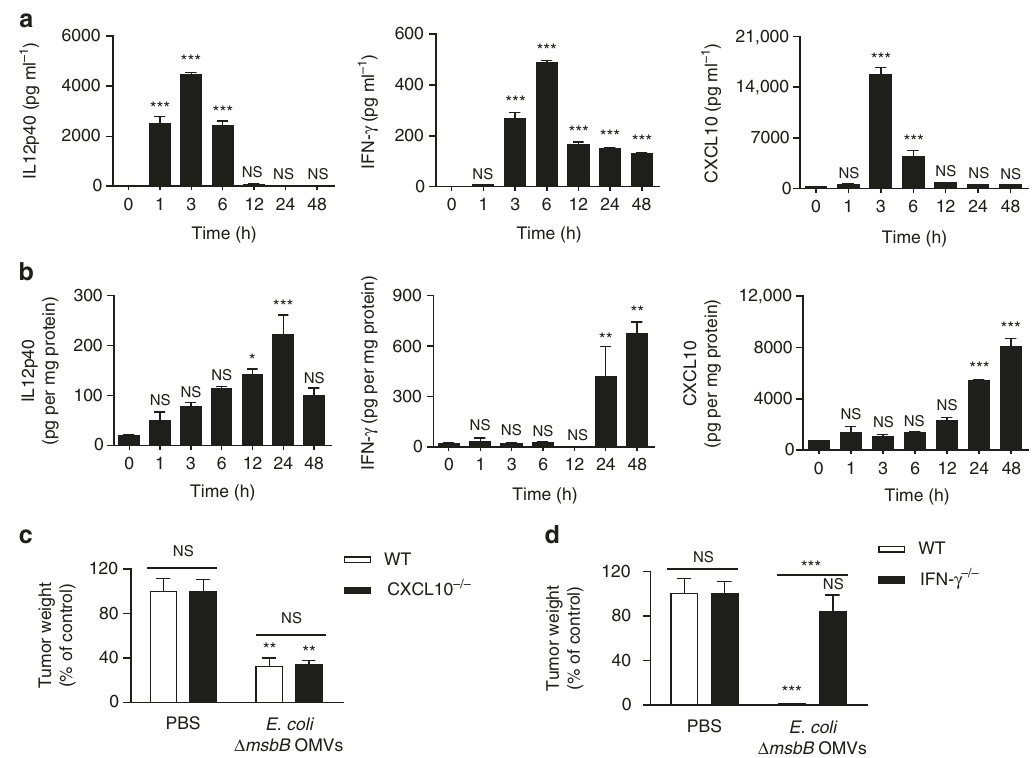
Fig. 4 E. coli Δ msbB OMV antitumor effect is IFN- γ dependent. a , b Release of antitumor cytokines IL-12p40, IFN- γ , and CXCL10 in blood sera a and tumor cell lysate b after single intravenous injection of E. coli Δ msbB OMVs (5 μ g in total protein amount) to mice bearing CT26 tumors at different time points. c , d The antitumor ef fi cacy of OMV treatment in CXCL10-de fi cient (CXCL10 − / − ) mice c and IFN- γ -de fi cient (IFN- γ − / − ) mice d . Data are shown as the mean ± SD ( n = 6 mice per group). NS, not signi fi cant, * P < 0.05, ** P < 0.01, and *** P < 0.001, respectively, analysed by one-way ANOVA. Bonferroni multiple comparisons post test was applied to compare each time point to zero time point a , b or to compare treated group with PBS group of each mouse c ,